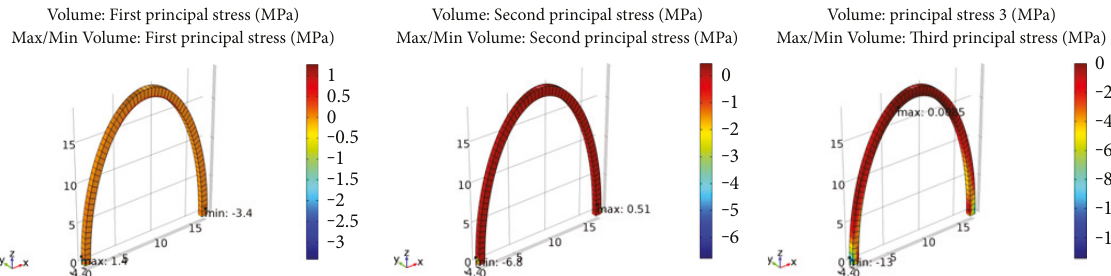
Figure 7: Magnitude and location of the maximum principal